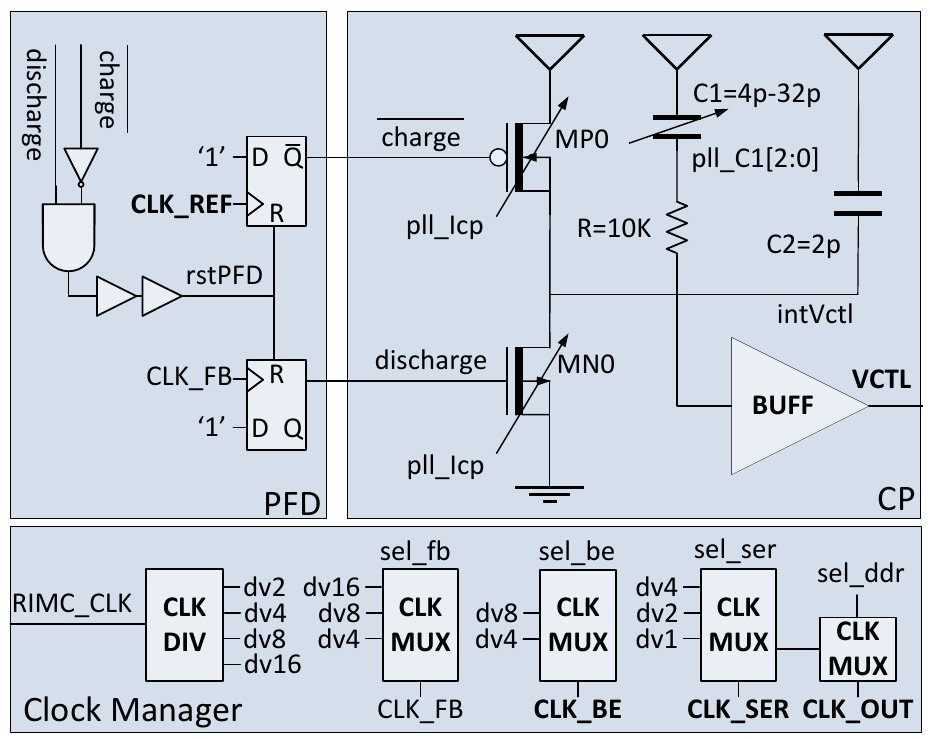
Figure 5. Simplified PLL schematic. Top-left: Phase-Frequency Detector (PFD). Top-right: Charge Pump (CP). Bottom: Clock Manager.